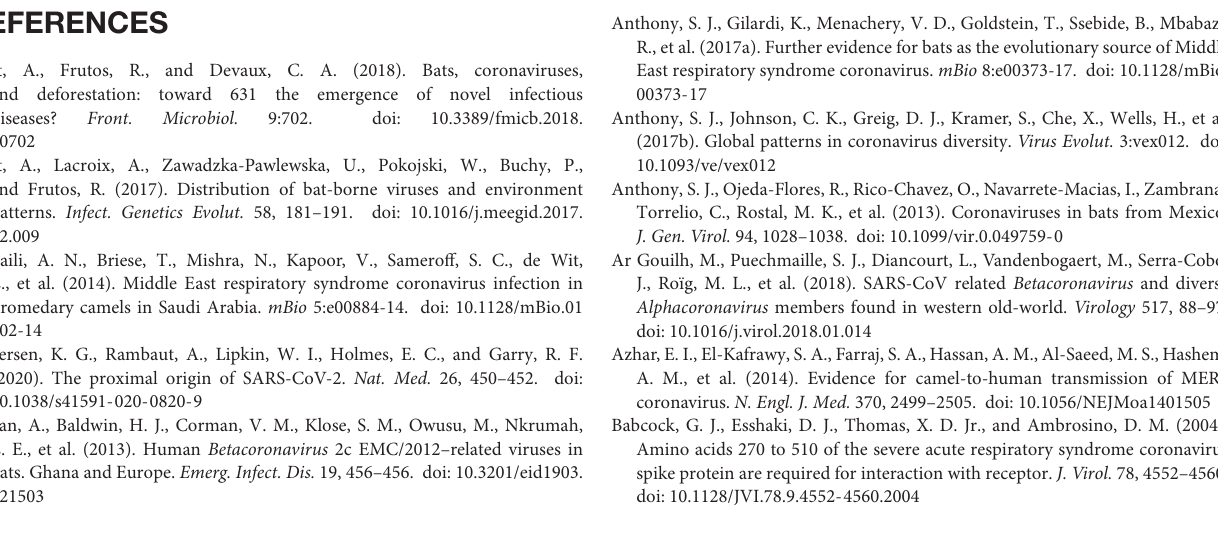
Supplementary Figure 3 | Distribution of Sarbecoviruses spike protein sequences. The alignment of the translated full spike genes was performed with MUSCLE from the SeaView package (Gouy et al., 2010). The tree was built using the maximum likelihood method under the LG model with 500 repeats. The tree